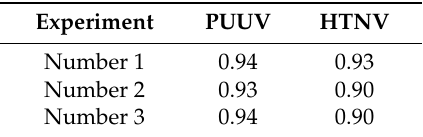
Table 1. Evaluation of the quality of the cell-based endonuclease